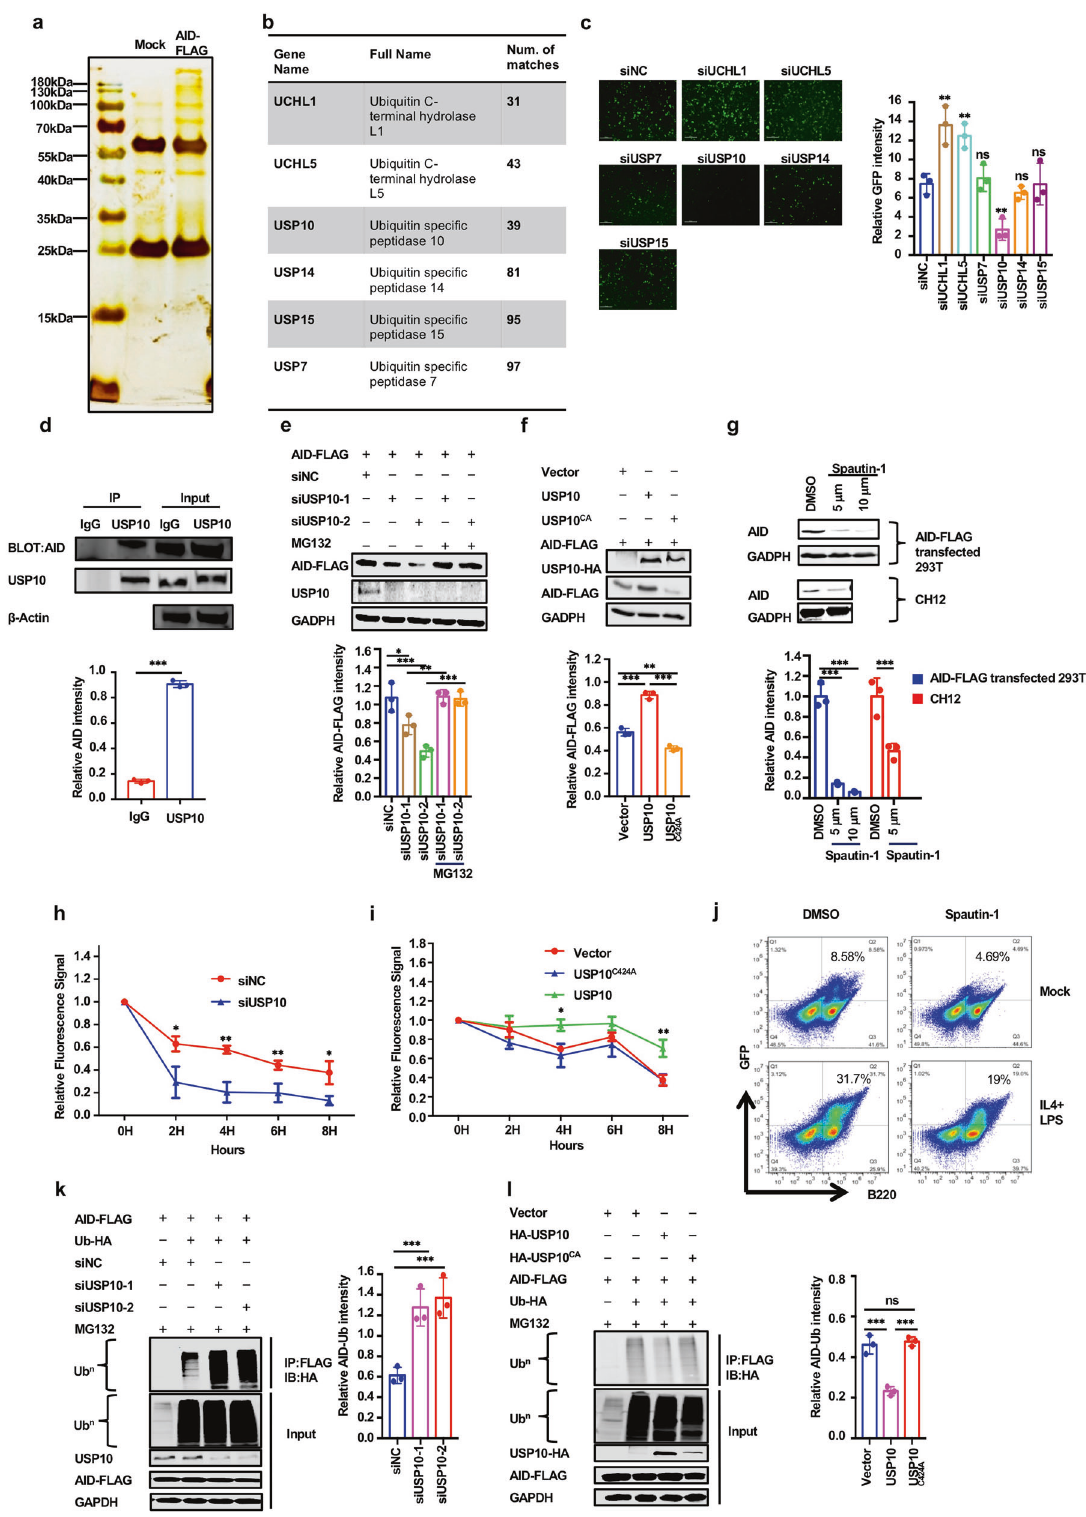
S38 and T140 increases the activity of AID, 24,27 whereas S3 phosphorylation reduces its activity. 26 AID is a nucleocytoplasmic shuttling protein. 28 Although it remains in the cytoplasm in a steady state, its function is restricted to the nucleus, where its protein levels and activities are tightly controlled. Rapid regulation of proteins by